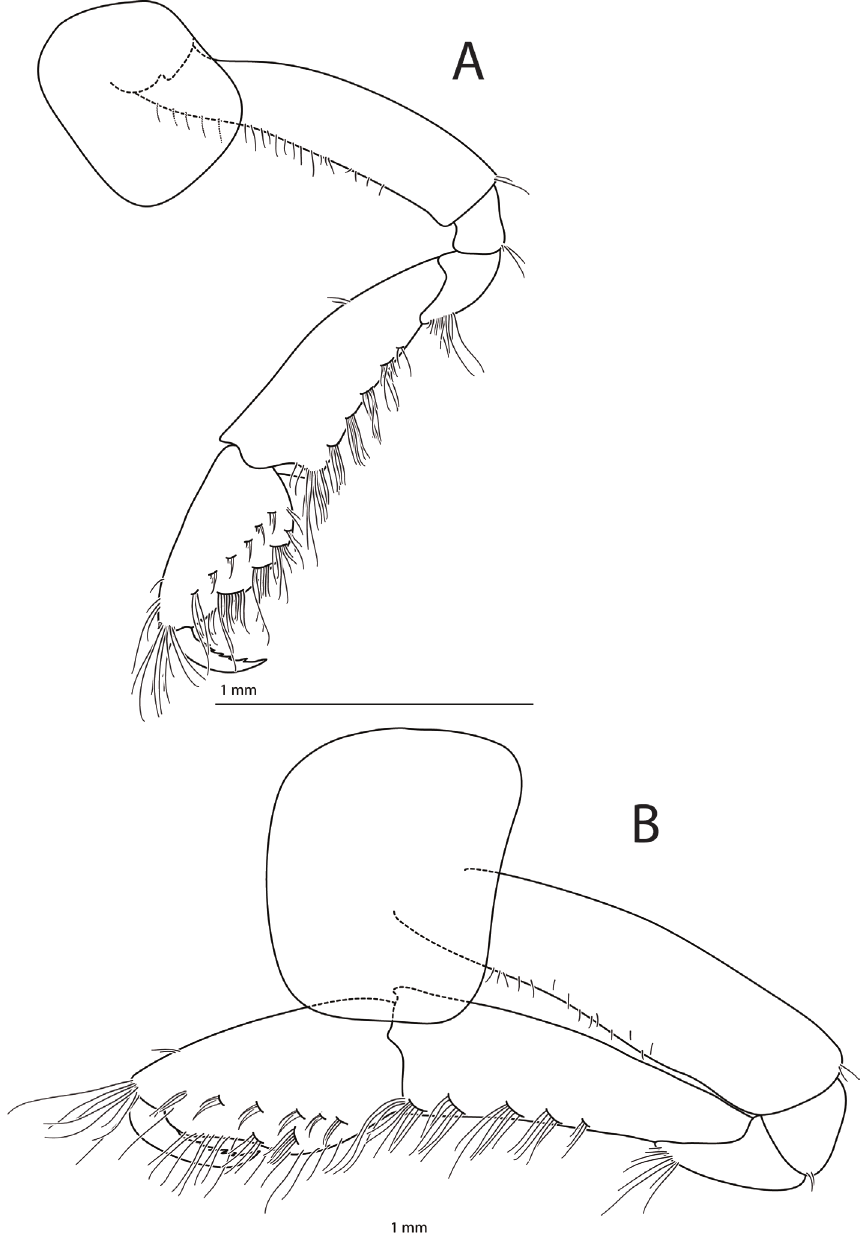
Fig. 5. Halirages helgae sp. nov., holotype, ♀ , 10 mm long. A . Gnathopod 1. B . Gnathopod